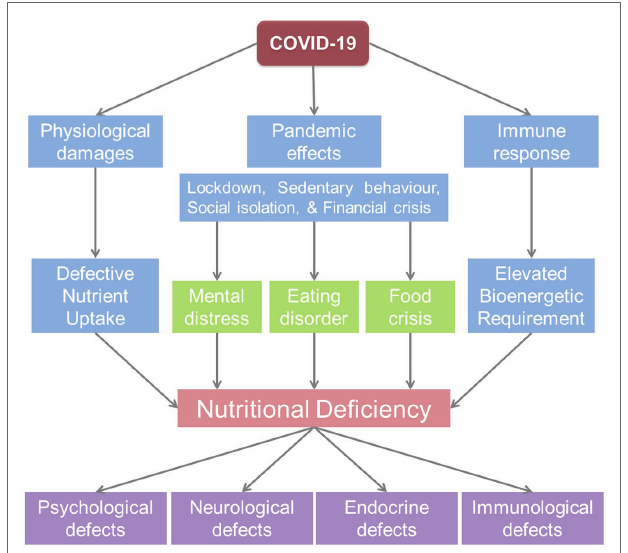
FIGURE 5 | Nutritional deficiency triggered by the COVID-19 pandemic can affect physical and mental health through psychoneuroendocrineimmune (PNEI)